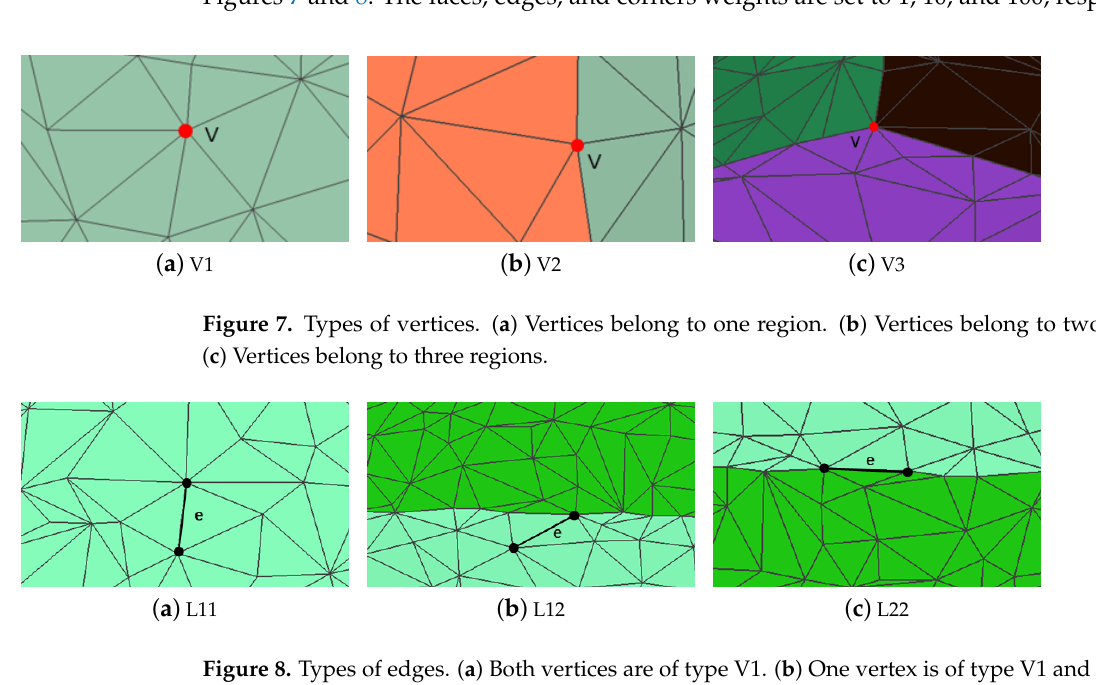
Figure 8. Types of edges. ( a ) Both vertices are of type V1. ( b ) One vertex is of type V1 and the other is of type V2. ( c ) Both vertices are of type